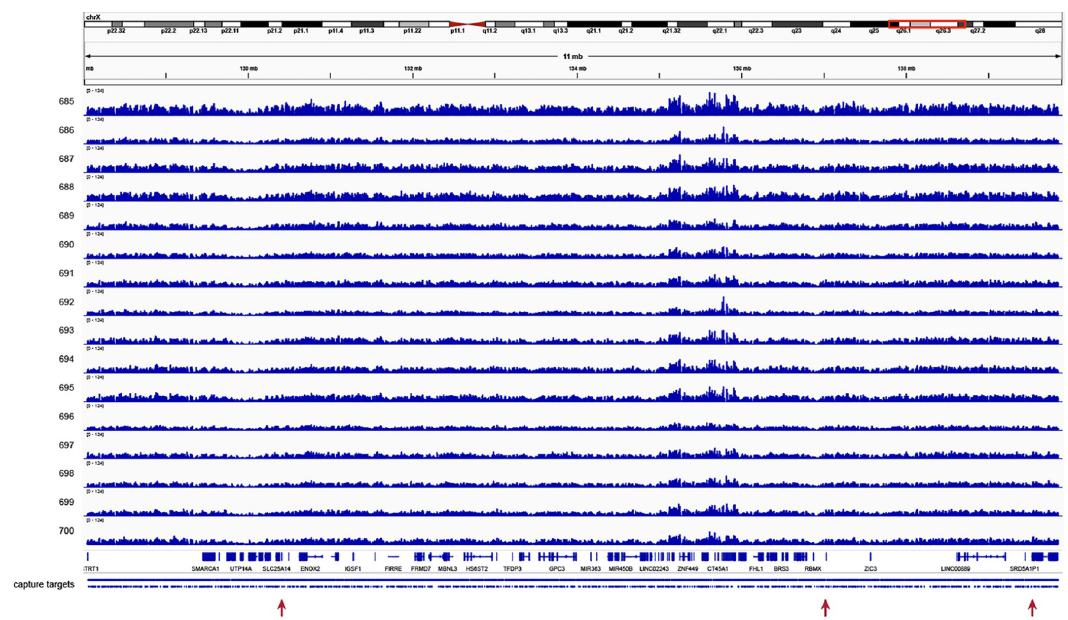
Fig 3. Sequencing coverage plot across the targeted 12Mb region on chromosome Xq24-q27 for all 16 family members. Each row represents the sequencing coverage for each family member separated by ID number. On the top, the chromosomal location is displayed and at the bottom, the genes and probe locations are shown. The red arrows indicate the locations of the three SVs that were highlighted in this study. The genes RBMX2 (ChrX:130,405,824–130,406,154) and F9 (ChrX:139,530,720–139,563,459) are not visible at this level of